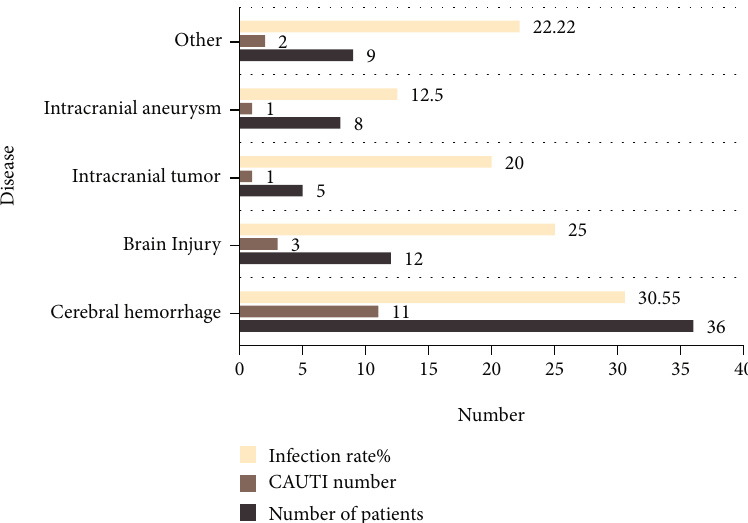
Figure 4: The impact of underlying diseases on